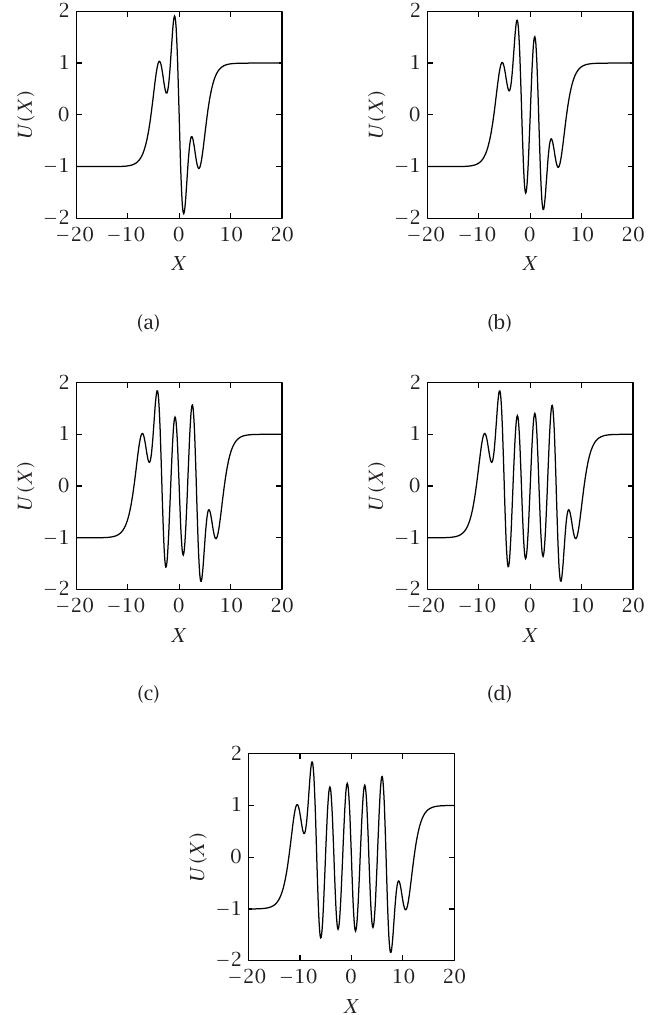
Figure 3.2 . Numerical solutions for the second family of regular shocks: (a) γ = 0 . 12394728, (b) γ = 0 . 11739917, (c) γ = 0 . 11839120, (d) γ = 0 . 11824900, (e) γ = 0 .